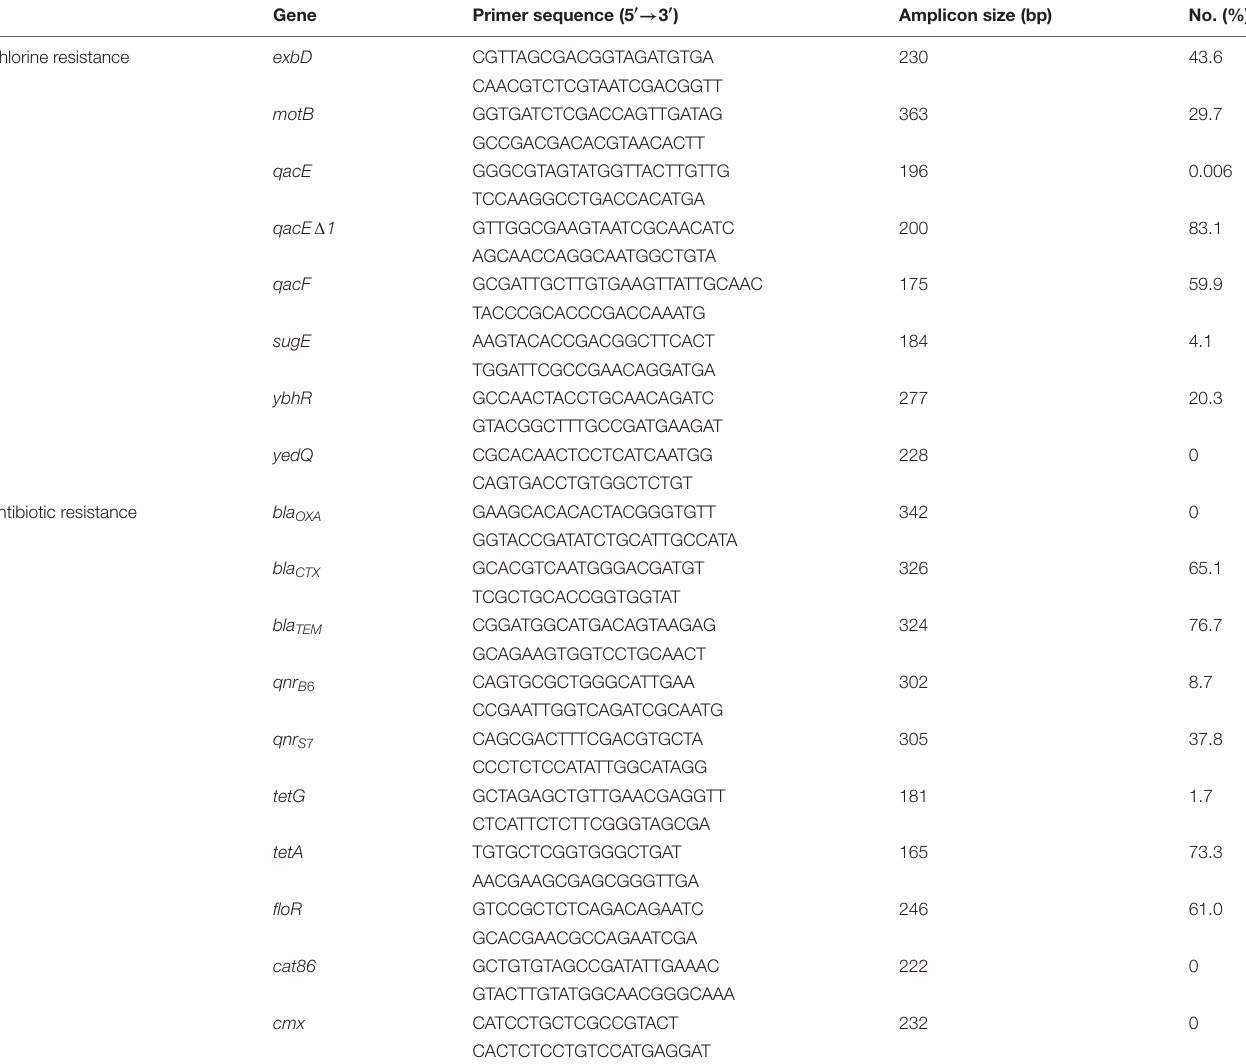
TABLE 1 | Frequency of chlorine tolerance and antibiotic resistance genes determined by PCR among Salmonella isolates ( n = 172). Gene Primer sequence (5 (cid:48) → 3 (cid:48)